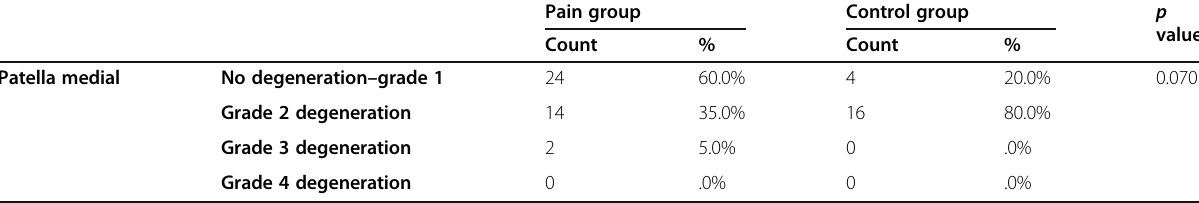
Table 2 Distribution of medial patellar degeneration according to ICRS degeneration grades Pain group Control group Patella medial No degeneration – grade